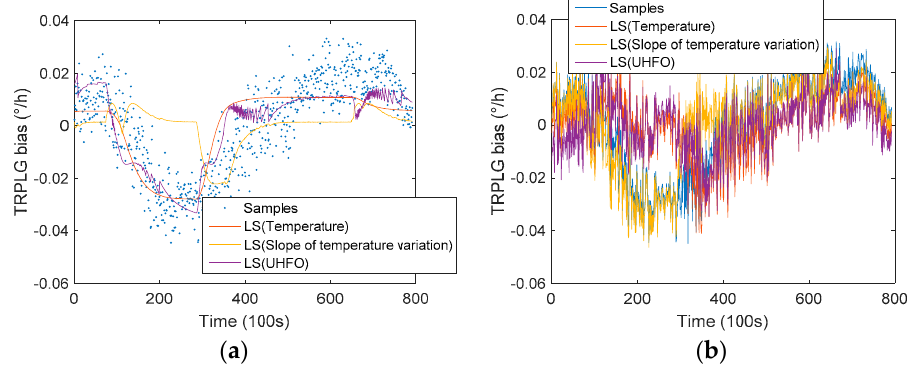
9 of 17 ( c ) Figure 6. The relationship between the TRPLG output and different parameters: ( a ) Temperature; ( b ) Slope of temperature variation; ( c ) UHFO. Table 1. Correlation coefficient between TRPLG output and parameters. Temperature Slope of Temperature Variation UHFO Correlation coefficient with TRPLG output 0.71 − 0.43 − 0.82 4. Analysis and Discussion of Results 4.1. Bias Compensation Using LS(least squares) Model